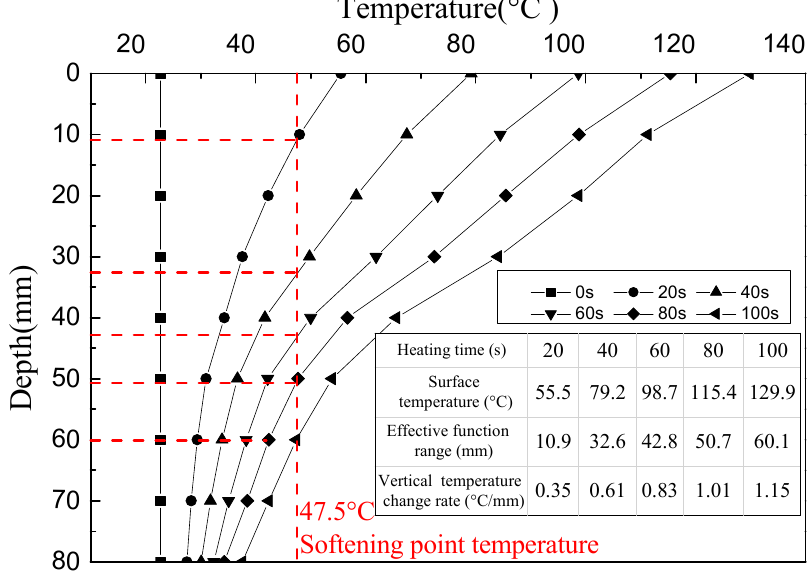
Figure 5. Vertical temperature distribution of the samples at a heating distance of 10 mm.